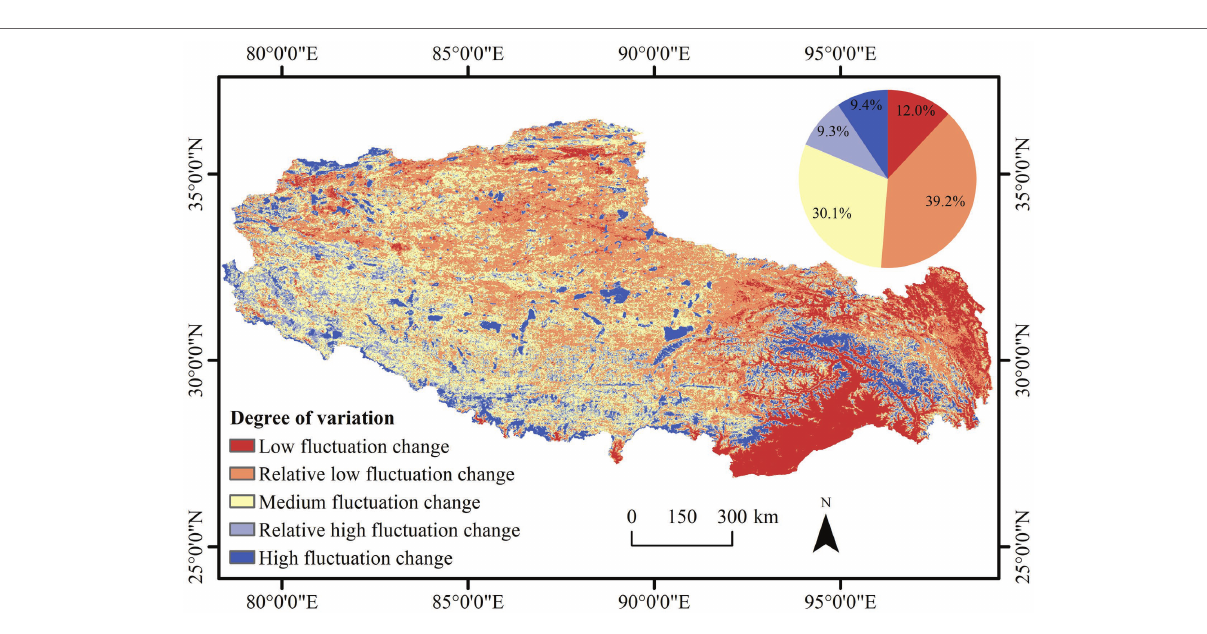
FIGURE 5 | Spatial distribution of the coefficient of variation of the NDVI from 2001 to 2020 in